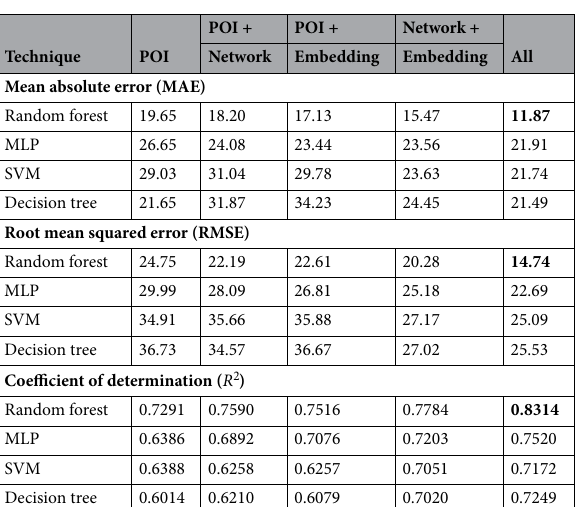
Table 3. Exploration of various machine learning techniques and feature combinations over an 80–20 data split (matching approach) for the city of Montréal, QC reflecting their top performing accuracy. Results represent MAE and RMSE errors over a range of 0–100 units, as well as R 2 . Significant values are in